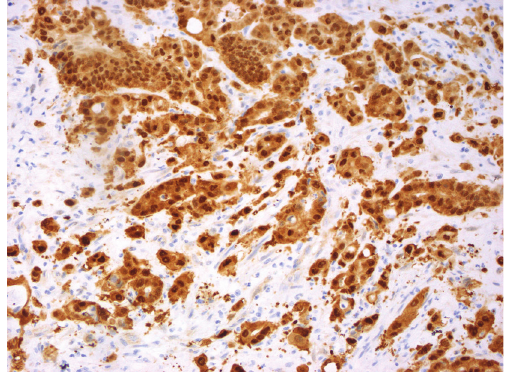
Figure 4: Representative example of immunopositivity grade 3 for β -catenin (original magnification ×